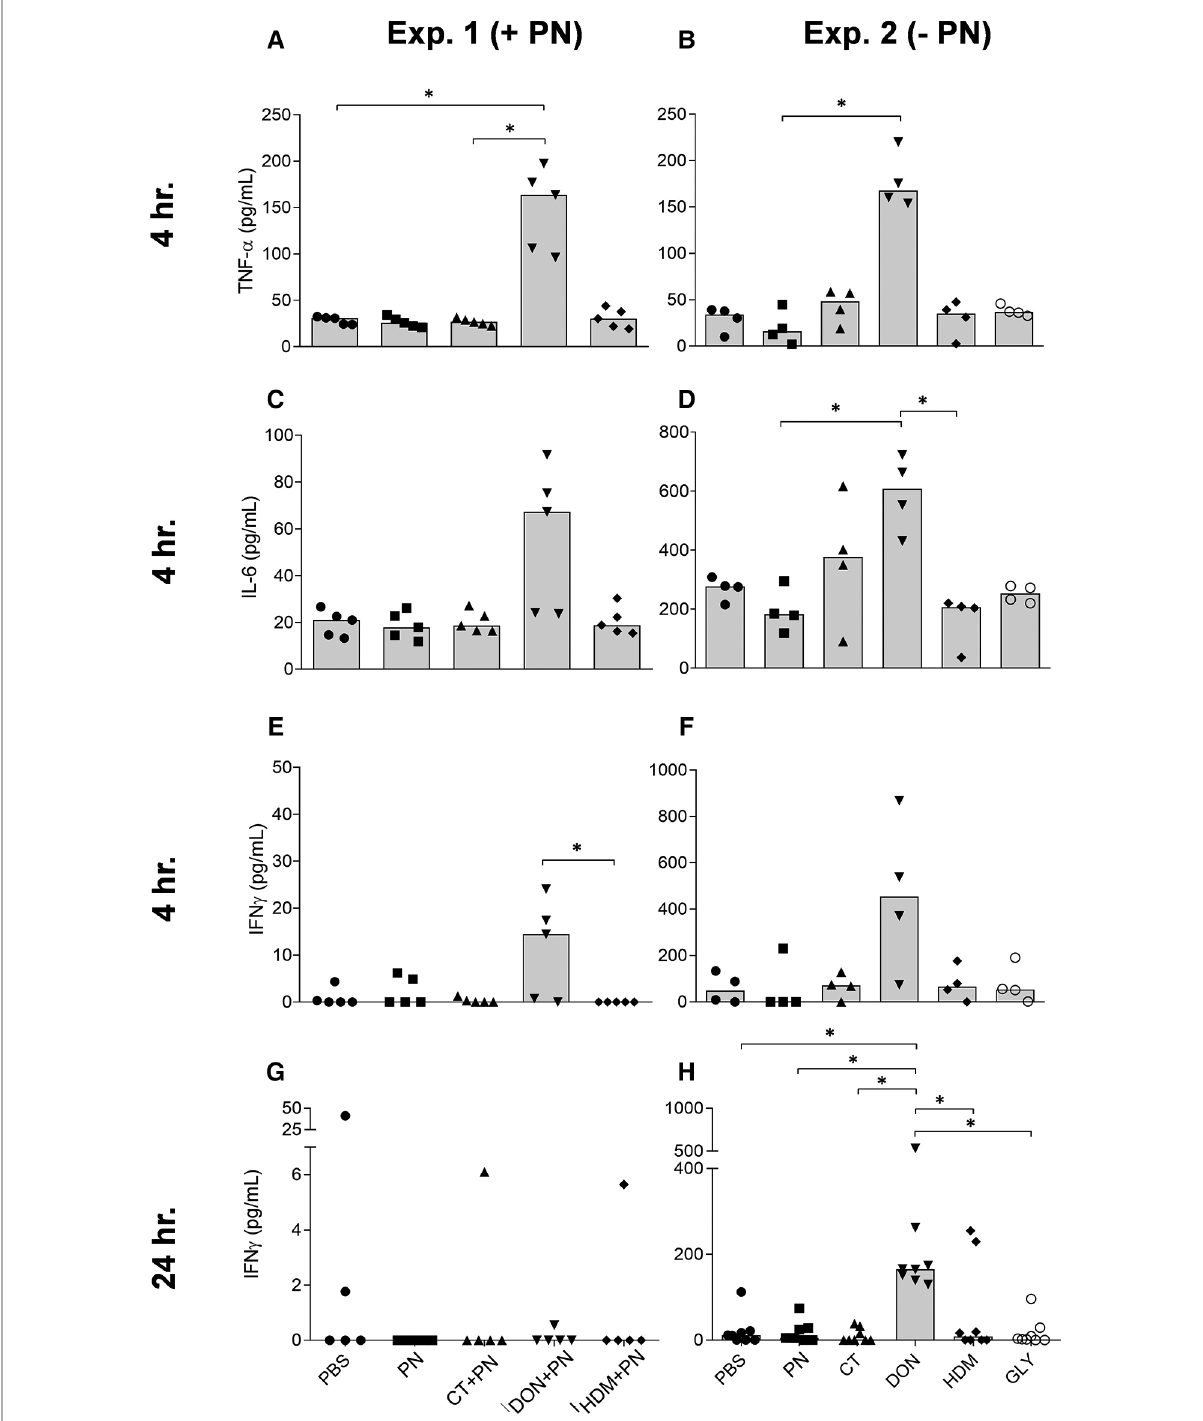
FIGURE 6 TNF- α , IL-6 and INF γ levels in MLN cells stimulated with LPS ex vivo, after a single i.g. dose of PBS, PN or a barrier disruptor with (exp. 1, n = 5) or without (exp. 2, n = 8) PN. The fi gures show levels of TNF- α ( A, B ), IL-6 ( C, D ), INF γ ( E, F ) 4 hours after exposure in exp. 1 ( A, C, E ) or exp. 2 ( B, D, F ). Also, levels of INF γ 24 h after exposure are shown for exp. 1 ( G ) and exp. 2 ( H ). Brackets denote statistically signi fi cant differences (* p < 0.05, ** p < 0.01). Columns denote the group median value while each symbol denotes the individual